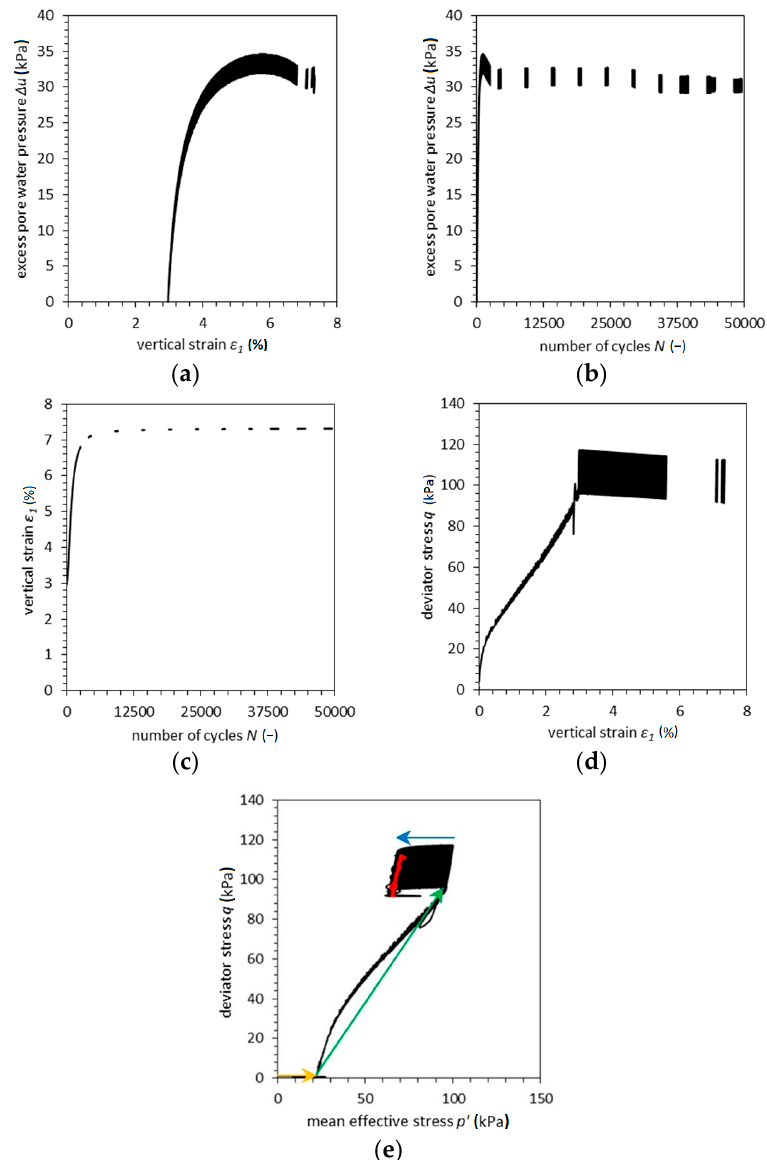
Figure 5. Results of the cyclic triaxial test for sandy silty clay under a confining pressure of 65 kPa and under the K 0 consolidation, initial void ratio e 0 = 0.333, K 0 = 0.67—sample 2.1: ( a ) Excess pore water pressure versus vertical strain characteristic, ( b ) excess pore water pressure characteristic versus number of cycles, ( c ) vertical strain characteristic versus number of cycle, ( d ) deviator stress–vertical strain relationship, and ( e ) the deviator stress–mean effective stress relationship (red color—last 10 cycles; arrow color—violet: Saturation phase, green: Consolidation phase, blue: Cyclic loading program).